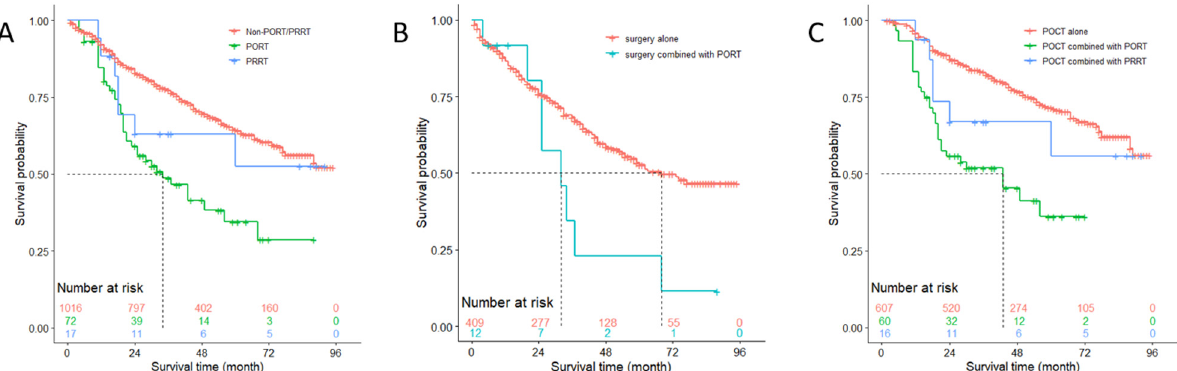
Figure 4. Overall survival of patients with N1 stage featured with <3 positive lymph nodes ( A ) who received Non- PORT/PRRT versus PORT ( p < 0.001), Non-PORT/ PRRT versus PRRT ( p = 0.471), and PORT versus PRRT ( p = 0.204); ( B ) who received surgery alone versus surgery combined with PORT ( p = 0.015); ( C ) who received POCT alone versus POCT combined with PORT ( p < 0.001), POCT alone versus POCT combined with PRRT ( p = 0.183), and POCT combined with PORT versus POCT combined with PRRT ( p = 0.380). POCT = postoperative chemotherapy; PORT = postoperative radiotherapy; PRRT = preoperative radiotherapy; Non-PORT/PRRT = neither PORT nor PRRT.